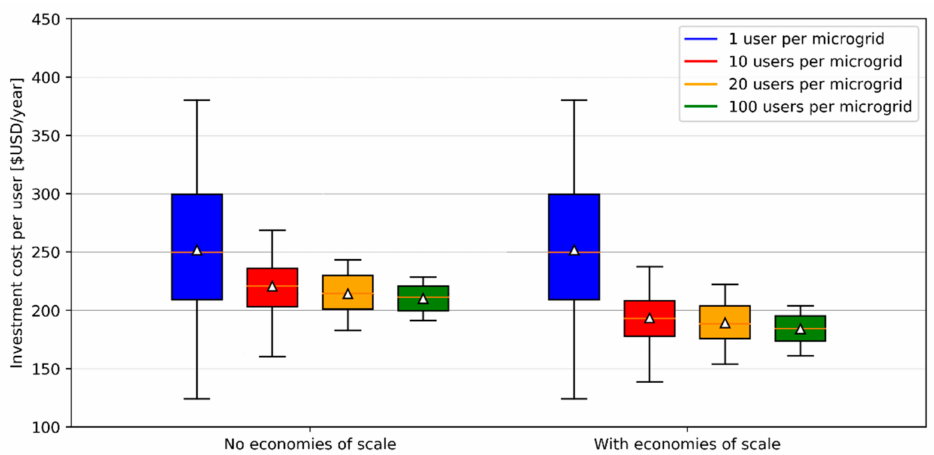
Figure 14. Distribution of investment costs per household, for microgrids determined from the stochastic approach, with reliability requirements (Case